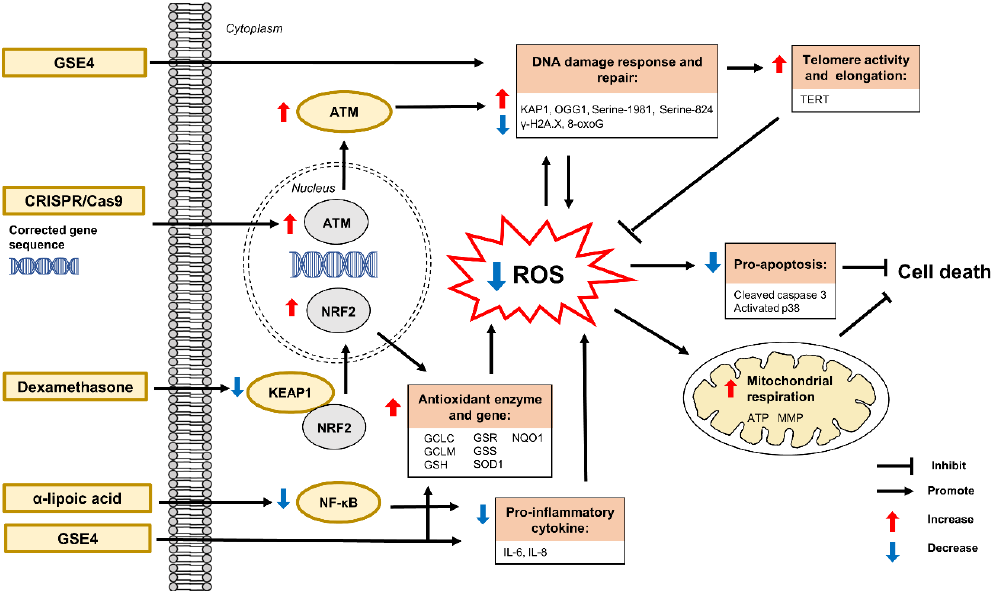
Figure 7. Antioxidant therapies against A-T. The defective ATM gene leads to the disruption of DNA damage response and repair, excessive production of ROS, and impairment of mitochondria. Antioxidant therapies can modulate ATM, NRF2, TERT, serine-1981, serine-824, KAP1 and γ -H2A.X expressions, and mitochondrial impairment, resulting in the restoration of DNA damage response and repair, antioxidant enzyme and gene levels, mitochondrial function, and telomere activity and elongation. This also leads to the attenuation of ROS production and pro-apoptotic activities. ATM, Ataxia-telangiectasia mutated; ATP, adenosine triphosphate; DNA, deoxyribonucleic acid; GCLC, glutamyl-cysteine ligase catalytic subunit; GCLM, glutamyl-cysteine ligase modifier subunit; GSEs, genetic suppressor elements; GSH, glutathione; GSR, glutathione reductase; GSS, glutathione synthetase; IL, interleukin; KAP1, KRAB-associated protein 1; KEAP1, Kelch-like ECH-associated protein 1; MMP, mitochondrial membrane potential; NQO1, NAD(P)H quinone oxidoreductase 1; NF-kB, nuclear factor kappa-light-chain-enhancer of activated B cells; NRF2, nuclear factor erythroid 2–related factor 2; OGG1, 8-oxoguanine DNA glycosylase-1; ROS, reactive oxygen species; SOD1, superoxide dismutase 1; TERT, telomerase reverse transcriptase; γ -H2A.X, gamma-H2A histone family member X; 8-oxoG, 8-oxoguanine. Table 2. Antioxidant therapies in the management of Friedreich’s ataxia.